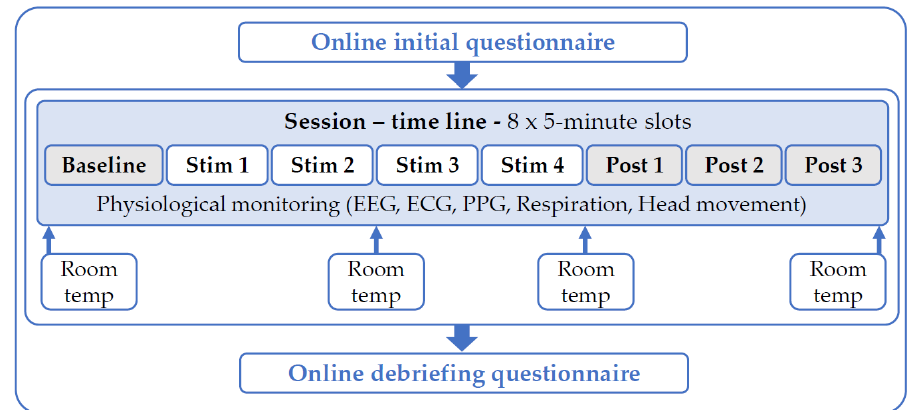
Figure 2. Timeline of the experiment.